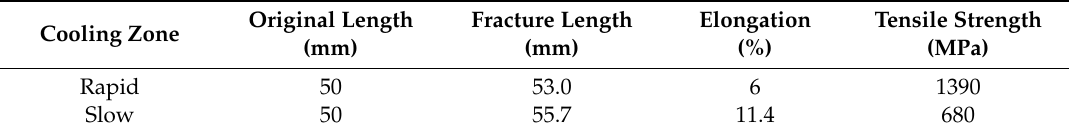
Table 7. Mechanical properties of the B-pillar in di ff erent